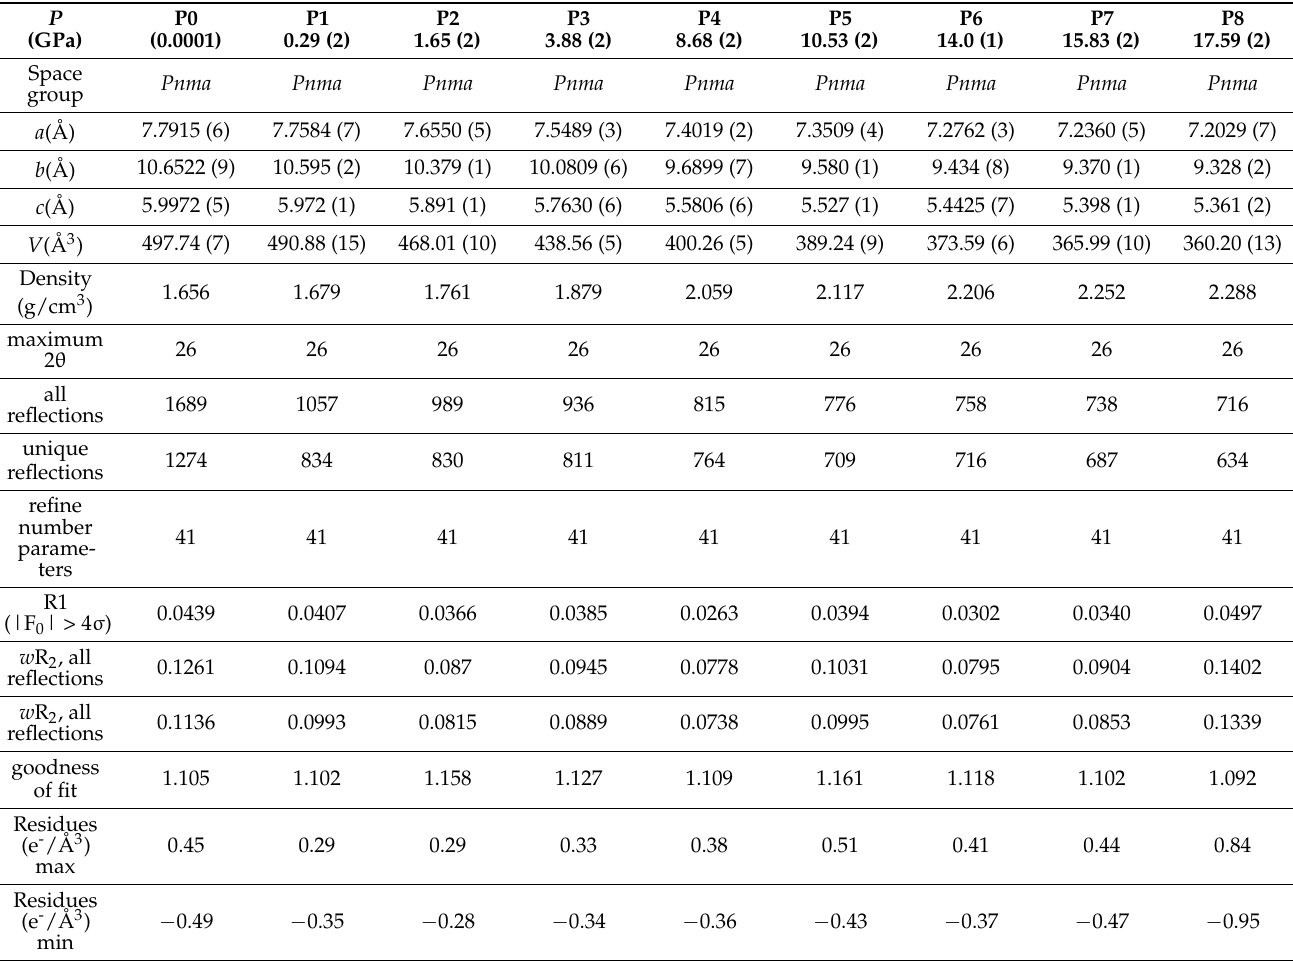
Table 1. Data collection details and refinement parameters of (NH 4 ) 2 SO 4 at different pressures.